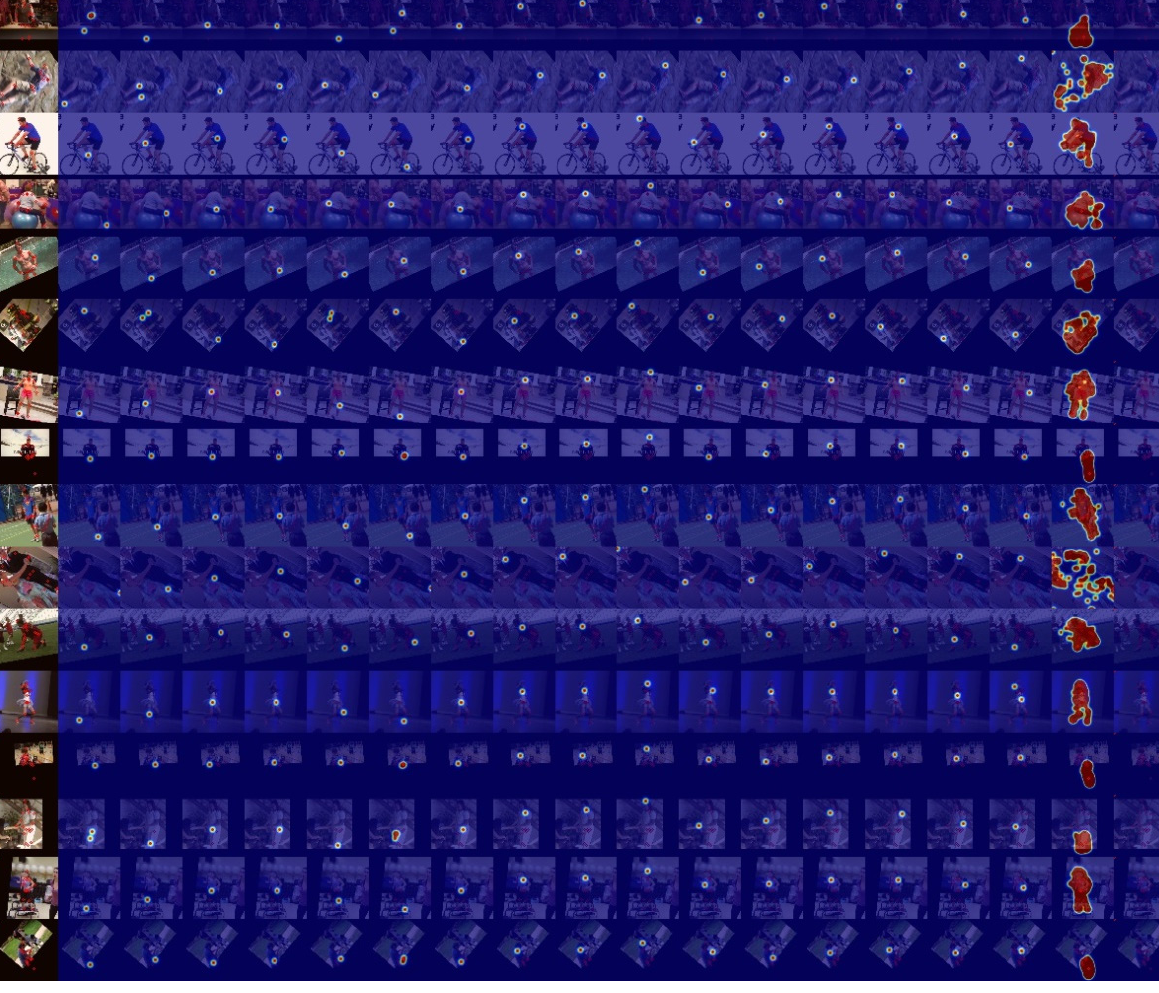
Figure 5. Visualization of Cofopose’s process of decoding for the keypoint detection transformer. Each row shows an overlay of heatmaps of 100 queries for all individual keypoints.